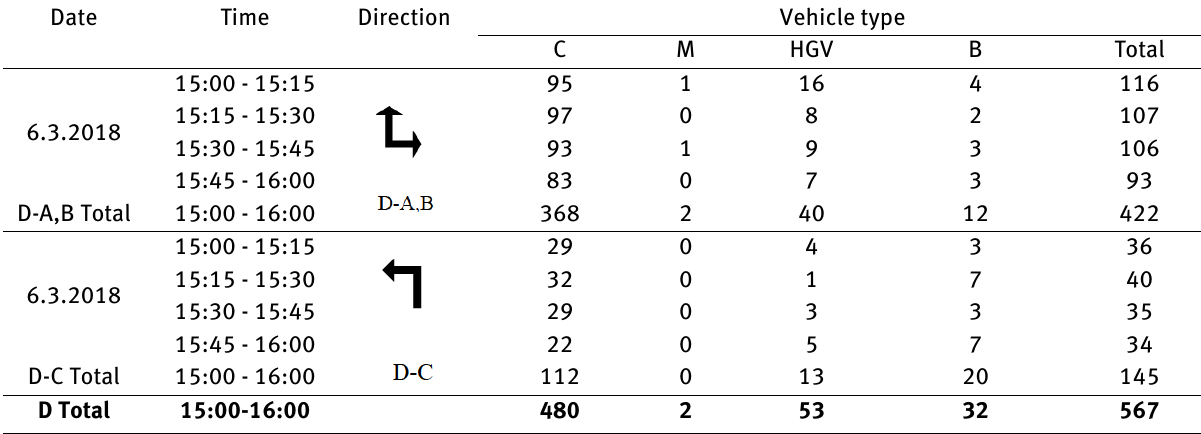
Table 3: Traflc intensity - results of traflc survey 1st day [30]